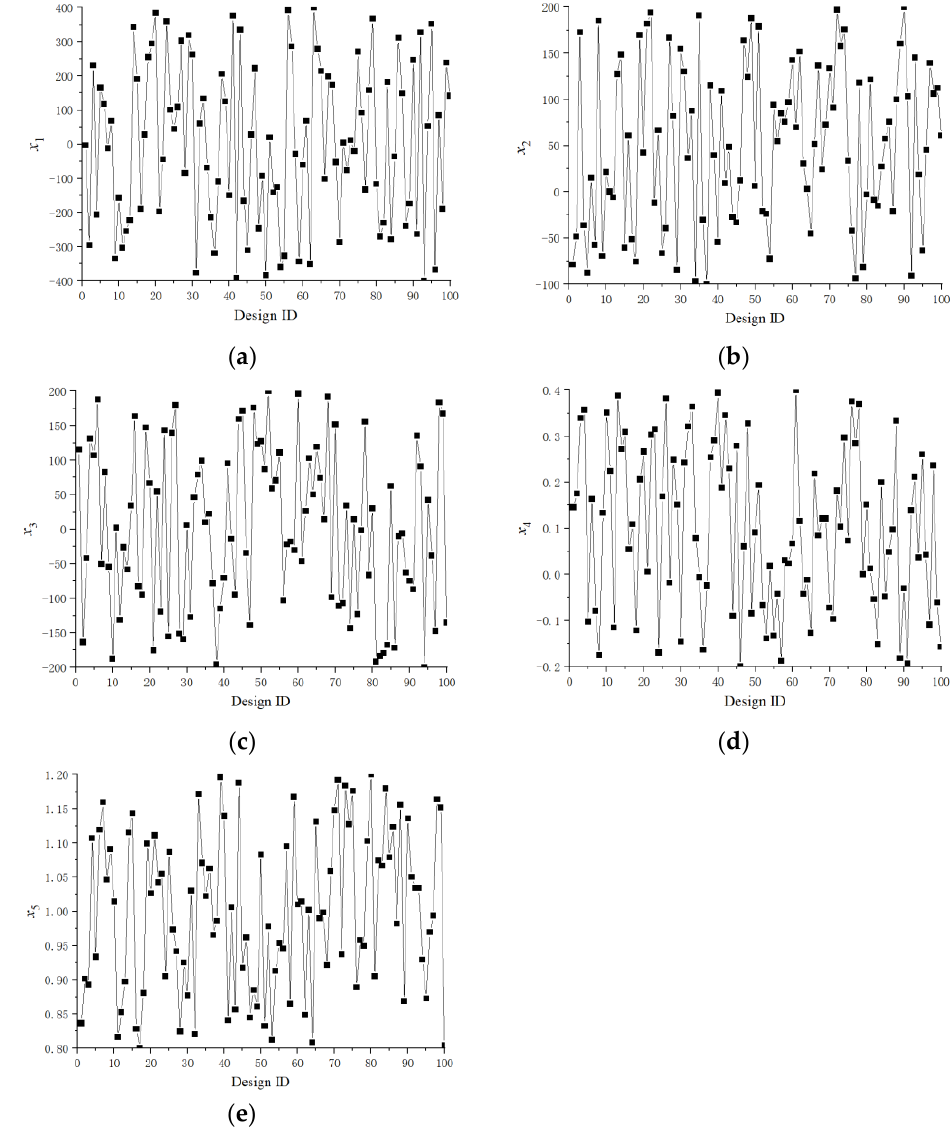
Figure 4. Experimental design points for each input variable: ( a ) x 1 , ( b ) x 2 , ( c ) x 3 , ( d ) x 4 , ( e ) x 5.